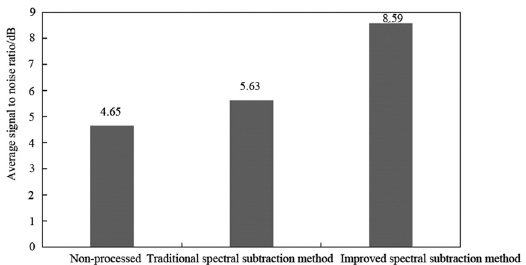
spectral subtraction methods.